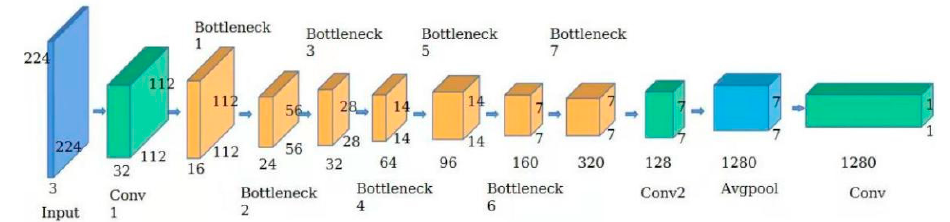
Figure 1. The MobileNetv2 network structure.